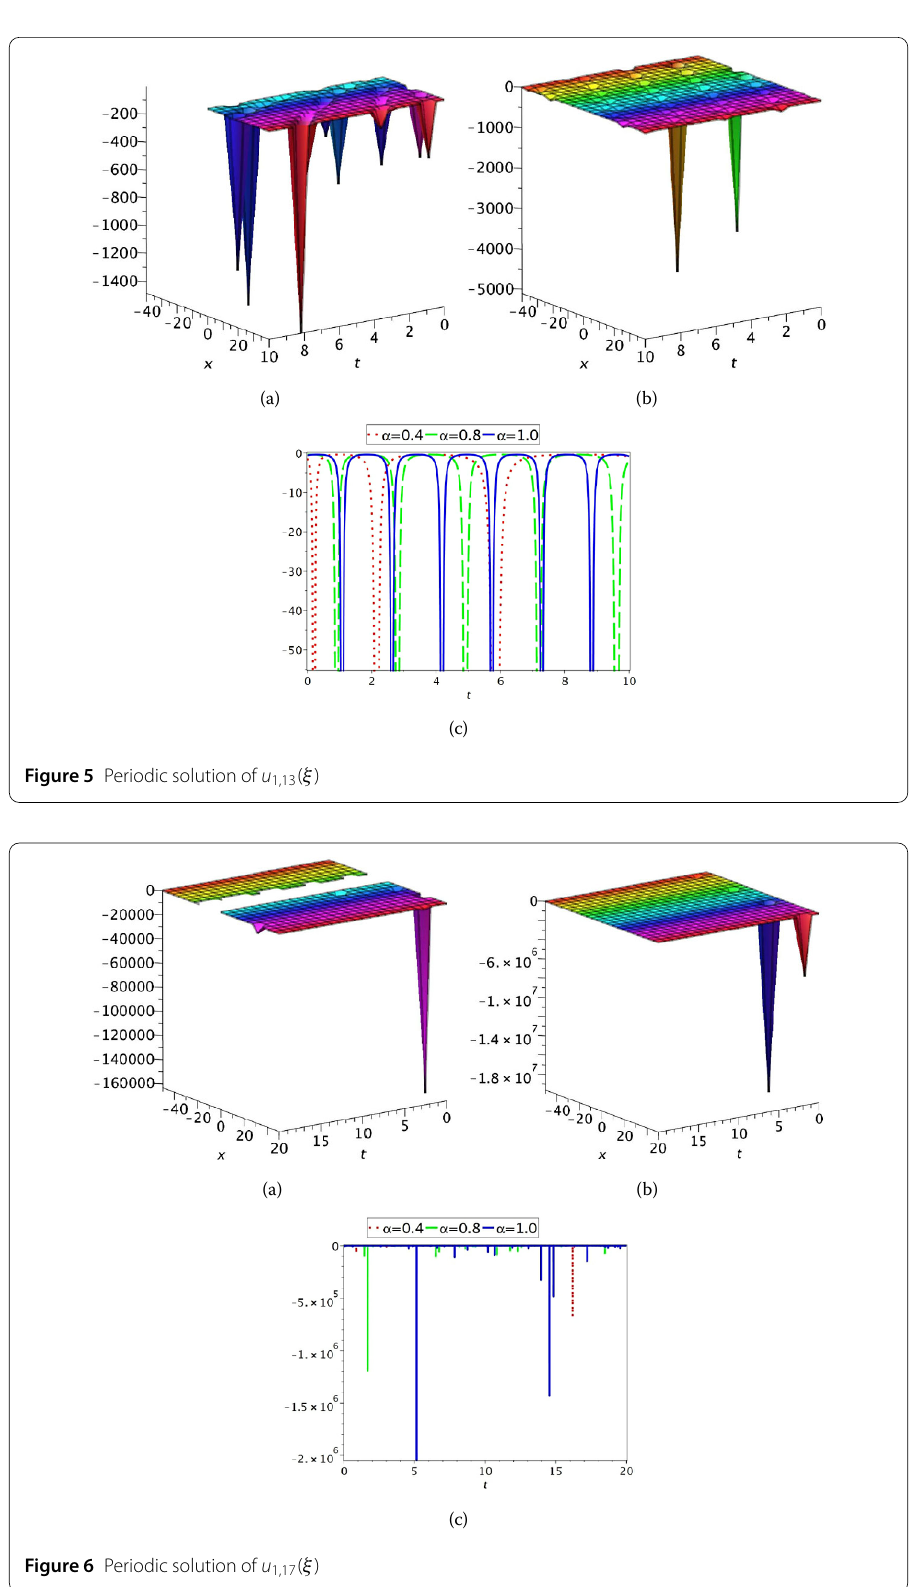
Figure 6 Periodic solution of u 1,17 ( ξ